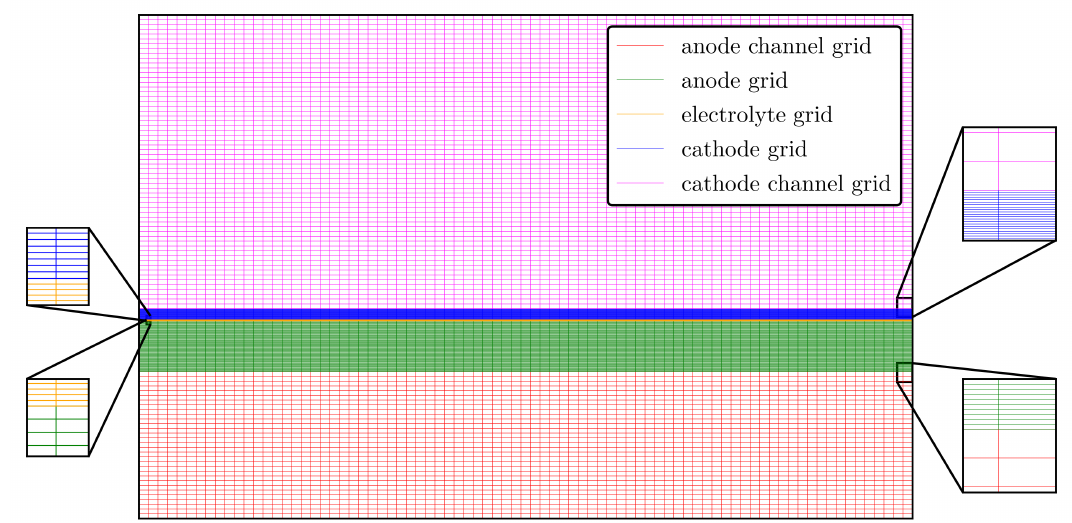
Figure 9. The grid system used for the